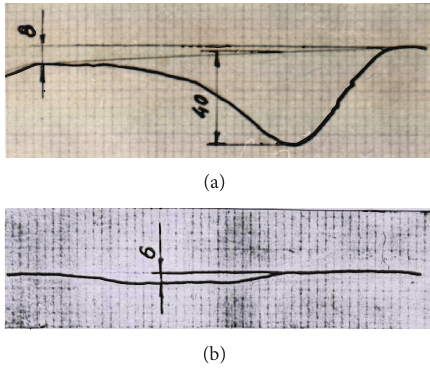
Figure 6: Profile diagram of unstraightness along the length of pro- cessing, vertical magnification × 500, and horizontal magnification × 0, 5: (a) without the use of the program device and (b) with the use of the program